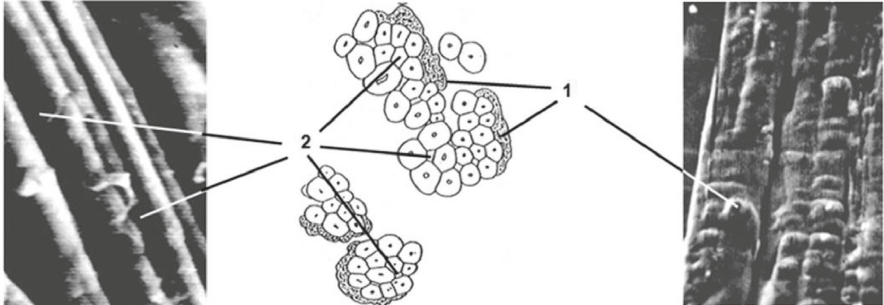
Figure 1: Incrusts (1) and inside intercellular space formations (2) from binders in the structure of the flax complexes.